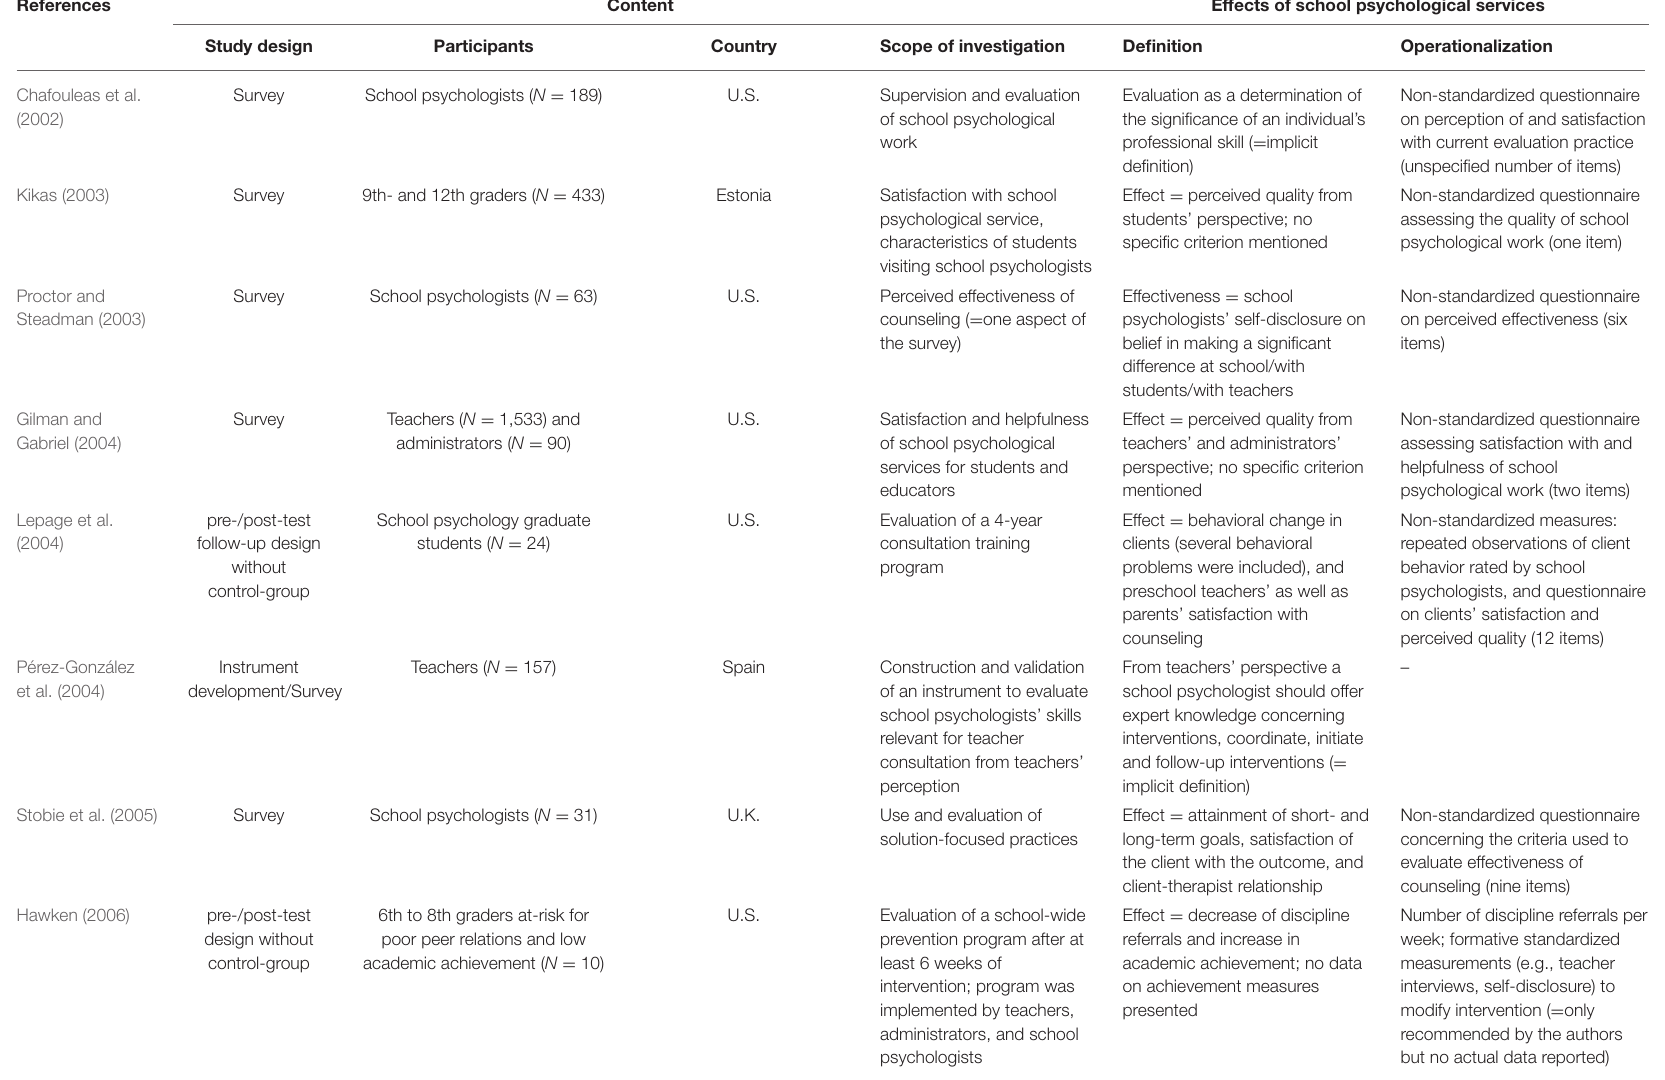
TABLE 3A | Summary of included empirical